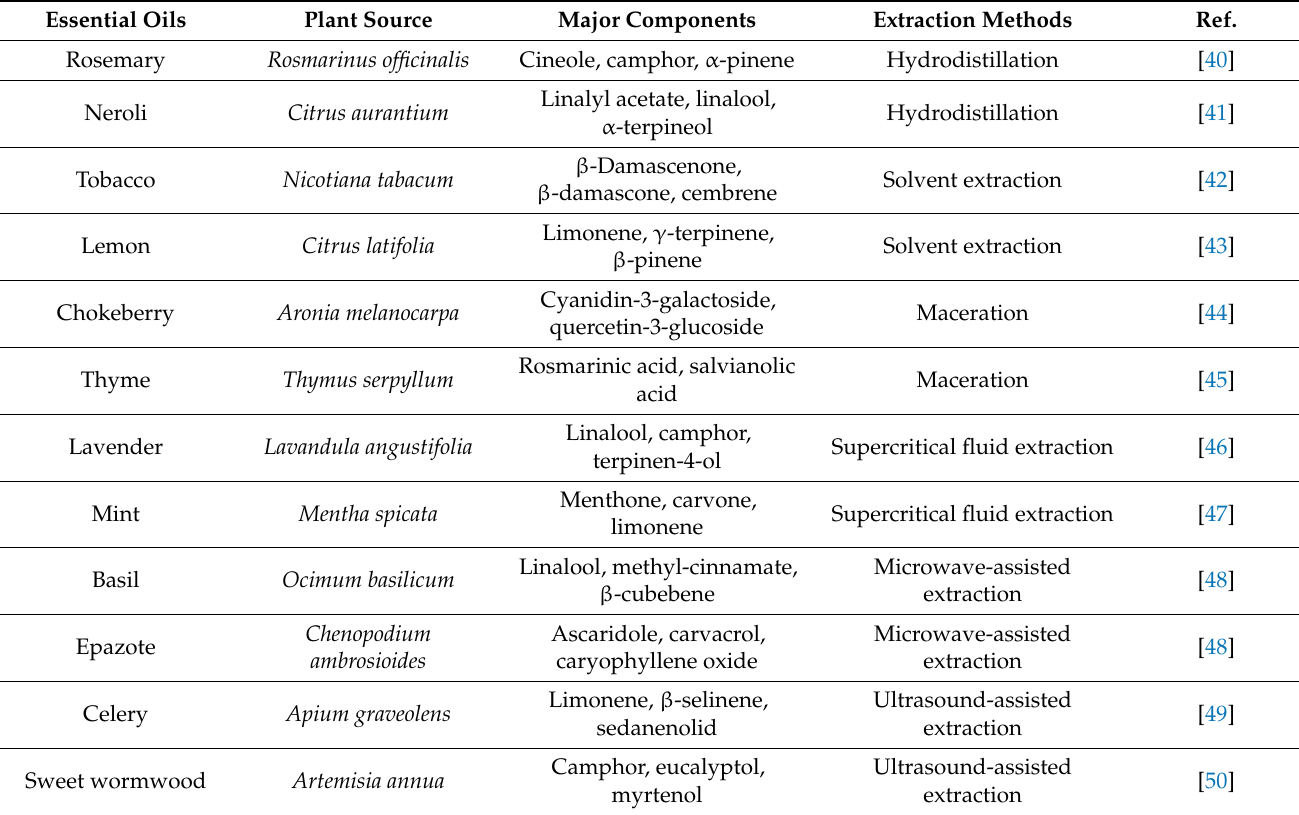
Table 2. Extraction of essential oils from various sources using different